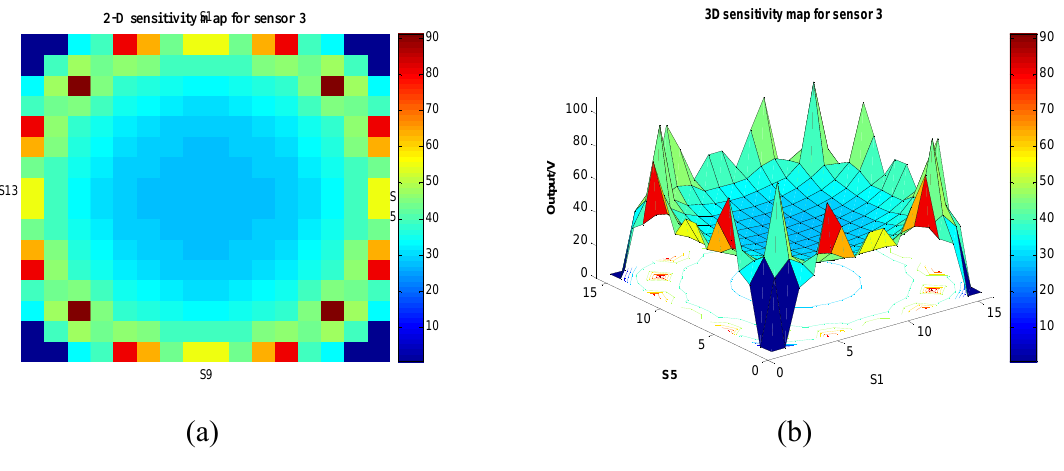
Figure 8. Summation sensitivity map S (a) Two-dimensional (b)